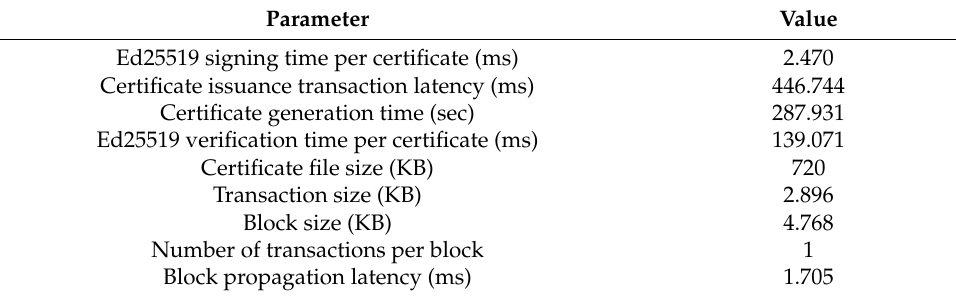
Table 8. E ‐ portfolio certificate issuance and verification performance. Table 8. E-portfolio certificate issuance and verification performance.